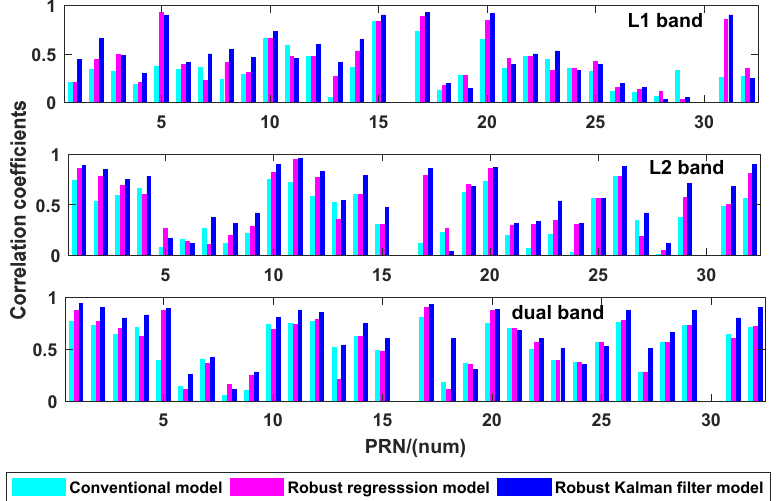
Figure 11. Correlation coefficients of three methods on each frequency with amplitude.